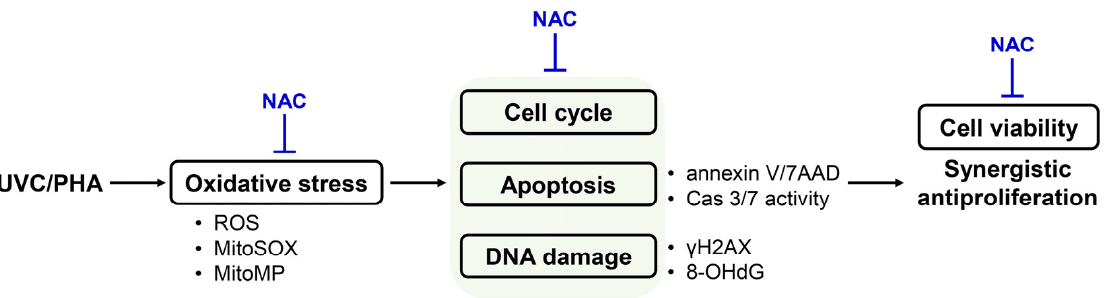
Figure 10. Synergistic molecular antiproliferation mechanism of UVC/PHA against oral cancer cells. In brief, the UVC/PHA combined treatment cooperatively generated more oxidative stress than separate treatments (UVC or PHA). Subsequently, the UVC/PHA-induced oxidative stress caused higher cell cycle disturbance, apoptosis, and DNA damage than UVC or PHA alone. Finally, these mechanisms of UVC/PHA action led to a synergistic antiproliferation effect against oral cancer cells. Moreover, NAC could suppress the UVC/PHA-associated changes, indicating that UVC/PHA induced an oxidative-stress-mediated synergistic antiproliferation effect against oral cancer cells. Supplementary Materials: The following are available online at www.mdpi.com/xxx/s1, Table S1: The synergy determinations ( α values) for all tested combined treatments with different UVC and/or PHA doses in oral cancer and normal cells.